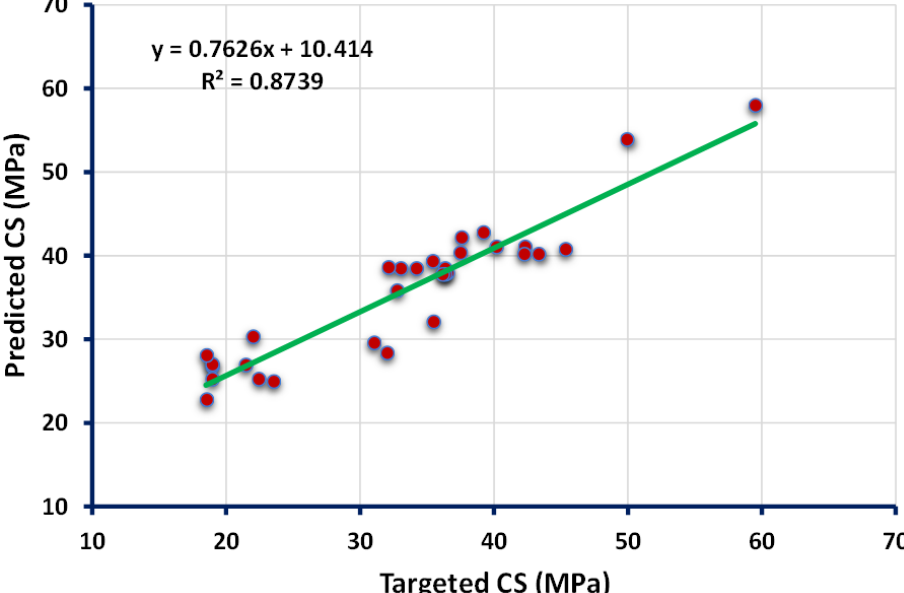
Figure 2. Relationship between the targeted and predicted results obtained from the ANN model.